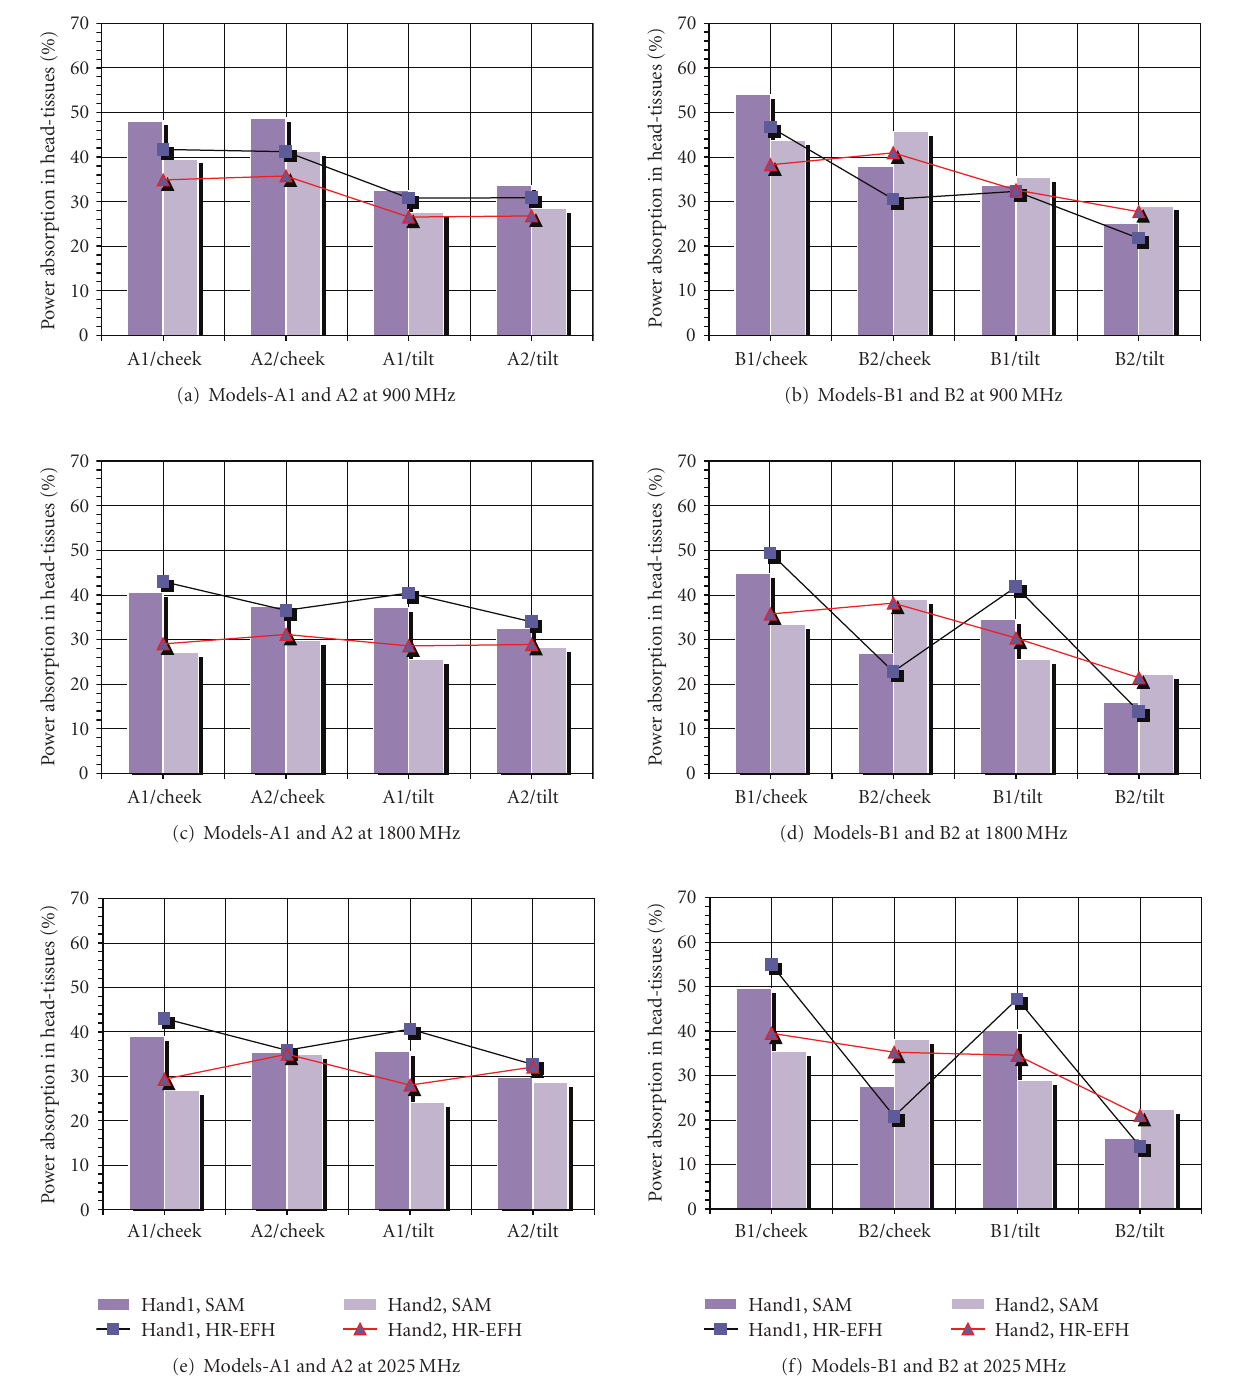
Figure 14: Percentage power absorption in head tissues at di ff erent antenna/handset positions in GSM900, GSM1800, and UMTS/IMT- 2000